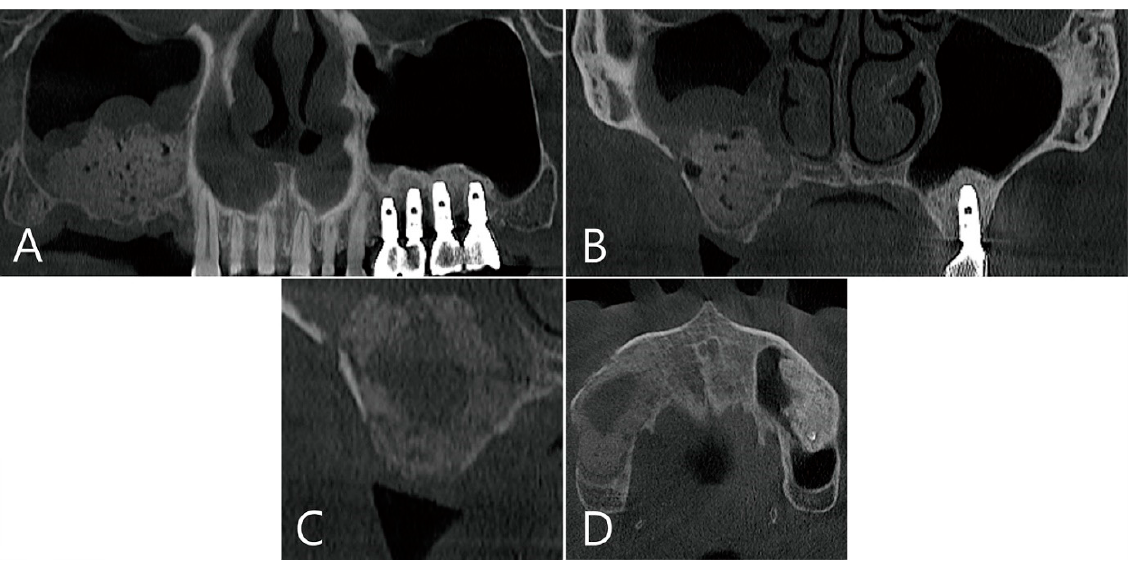
Figure 8. Case 3. CBCT images taken immediately after maxillary sinus bone graft: ( A ) On the panoramic image of CBCT, a thickened mucosa on the sinus floor was observed above the bone graft; ( B ) Coronal image of the CBCT. ( C , D ) Images of the CBCT taken 6 months after surgery: ( C ) in the coronal image of the CBCT, large grafting voids with a cystic appearance were observed; ( D ) a well-defined radiolucent appearance was observed on an axial image of the CBCT.